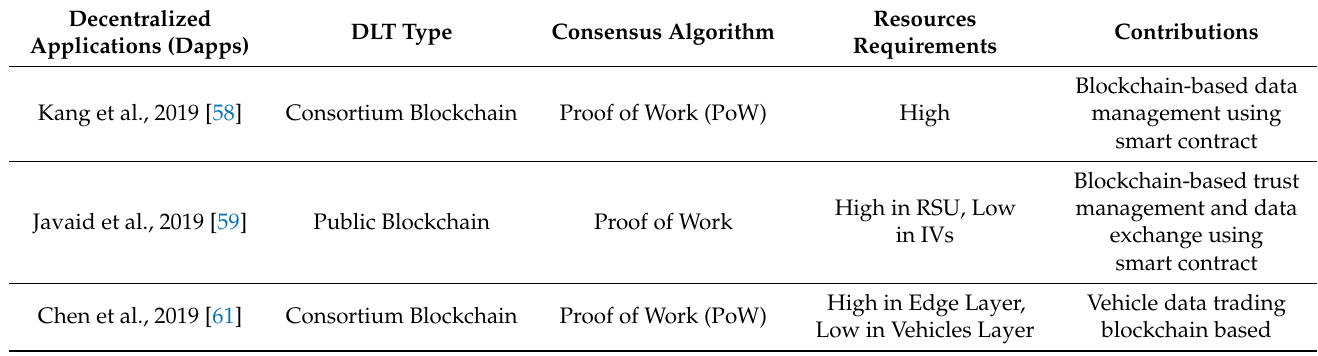
Table 3. A Comparative Perspective of DLT-Based Previous